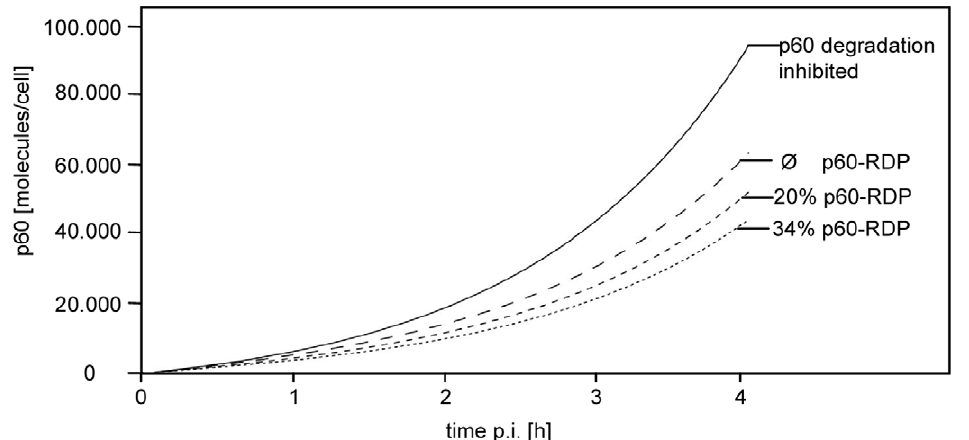
Figure 4. Mathematical modelling of p60 accumulation in infected cells. The intracellular accumulation of p60 was modeled in the absence of p60-RDP using the experimentally determined p60 half-life of 106 min (Ø RDP) or under the assumption that 20% or 31.5% of p60 is rapidly degraded with the predicted half-life of 3.4 min whereas the remaining p60 fraction decays with a half-life of 106 min. In addition the accumulation of p60 was modeled without p60 decay (solid line). For the calculations equation 9 from appendix S1 was used. The initial number o bacteria per cell